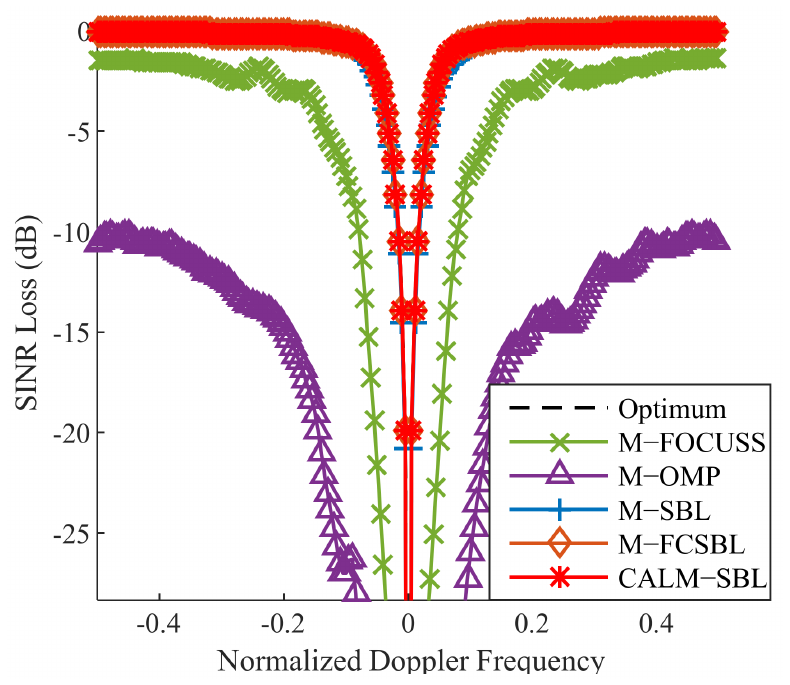
Figure 6. SINR loss comparison of different SR-STAP